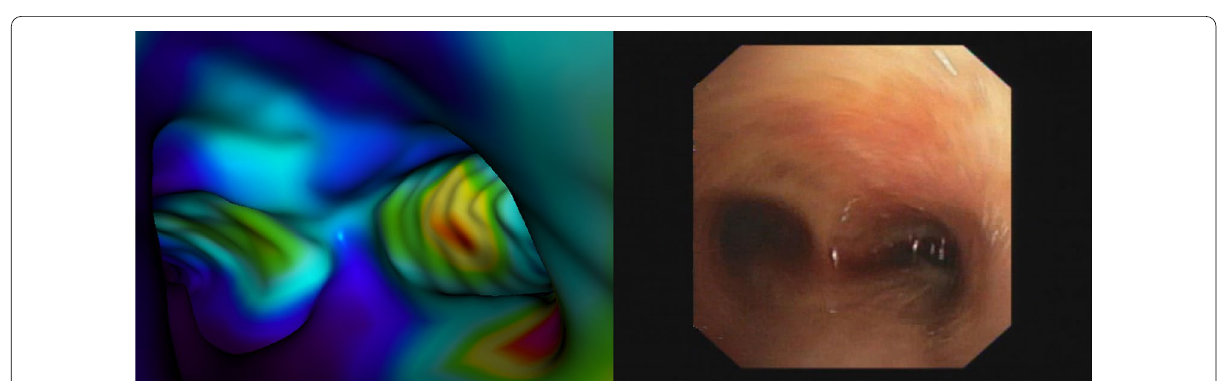
Fig. 3 Visualisation of the bifurcation point, as it can be seen from the trachea. The segmented trachea defines the geometry, while the texture originates from the radioactivity accumulated in pixels located 10 mm or closer to the outer surface of the trachea (panel A ). Real bronchoscopic photograph of the same carinal region (panel B